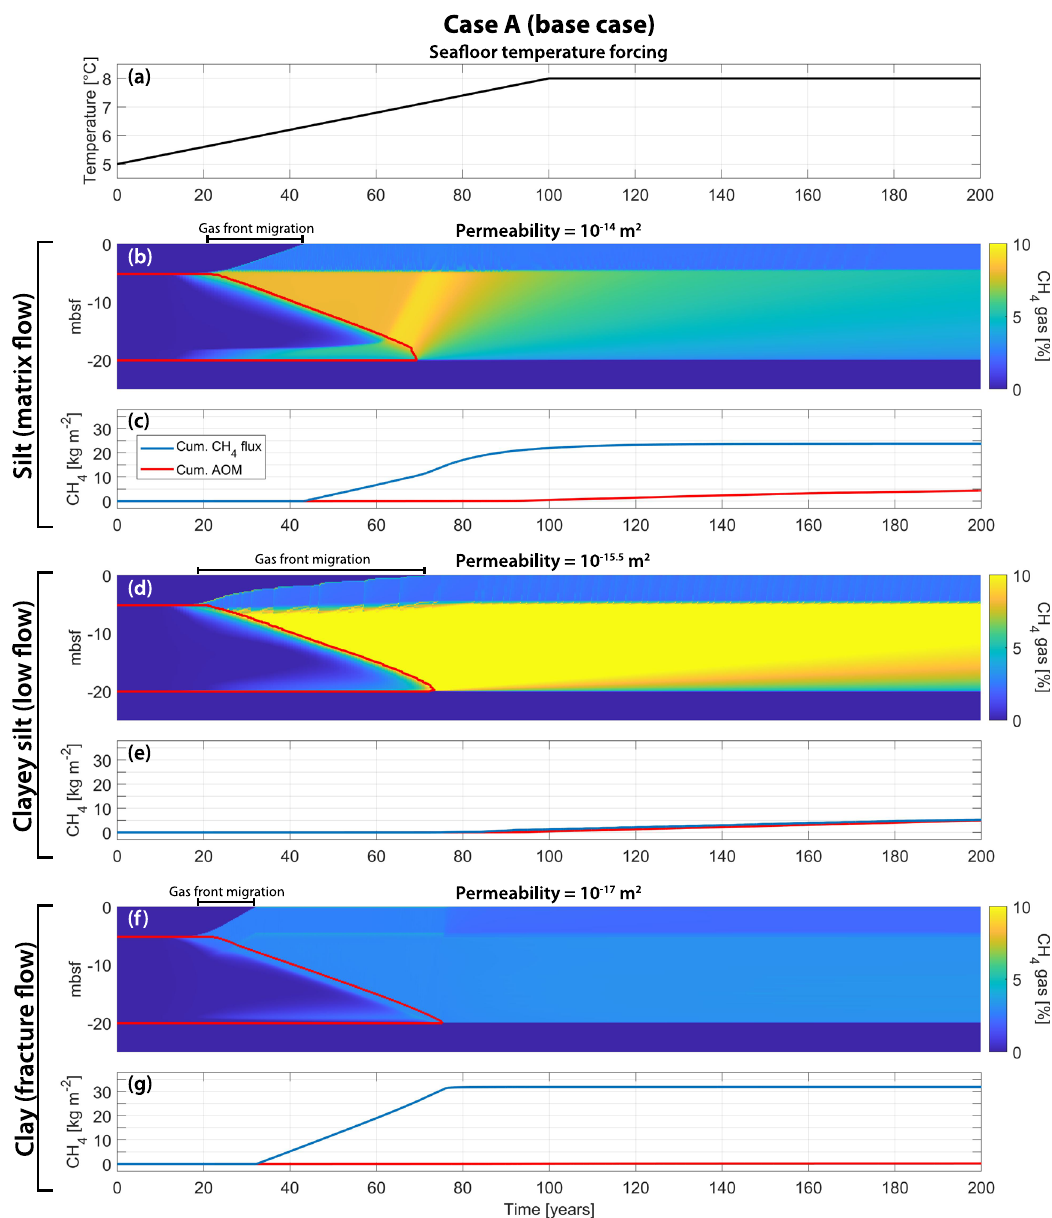
Fig. 3 Simulation results from Case A (base case). a Sea fl oor temperature forcing. Simulation output for high permeability sediments dominated by matrix fl ow are shown in ( b , c ), medium permeability sediments with comparably low fl ow are shown in ( d , e ) and low permeability sediments dominated by fl ow through hydraulic fractures are shown in ( f , g ). CH 4 gas concentration within the sediment pore space is shown as a function of simulation time ( b , d , f ) with the red contour marking the depth boundaries of the hydrate deposit thinning with time due to the ongoing hydrate dissociation. Cumulative gas release at the sea fl oor (solid blue), cumulative AOM (solid red) are shown as functions of time ( c , e , g